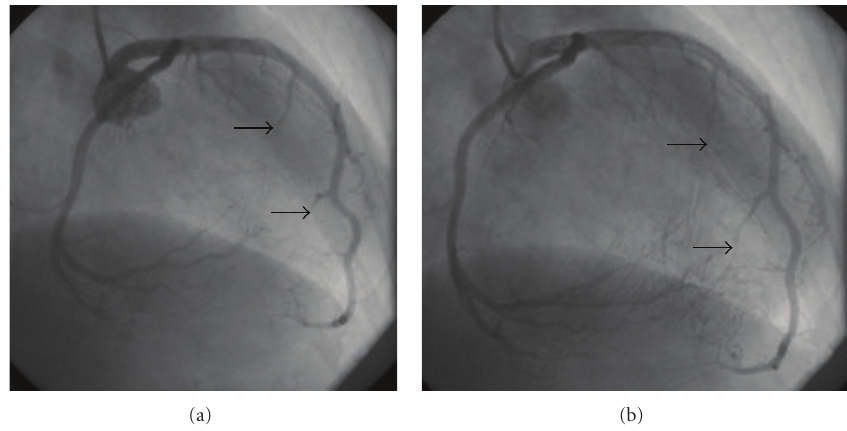
Figure 1: Systolic compression of septal perforators of LAD (a) is seen during systole whereas arteries are fully opened during diastole (b).